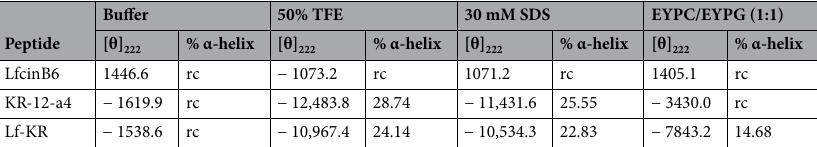
Table 4. Mean residual ellipticity at 222 nm ([θ] 222 ) and percent α-helical contents of LfcinB6, KR-12-a4 and Lf-KR in aqueous buffer, 50% TFE, 30 mM SDS and EYPC/EYPG (1:1) vesicles. % α-helix = − 100 ([θ] 222 + 3000)/33,000. rc random coil.